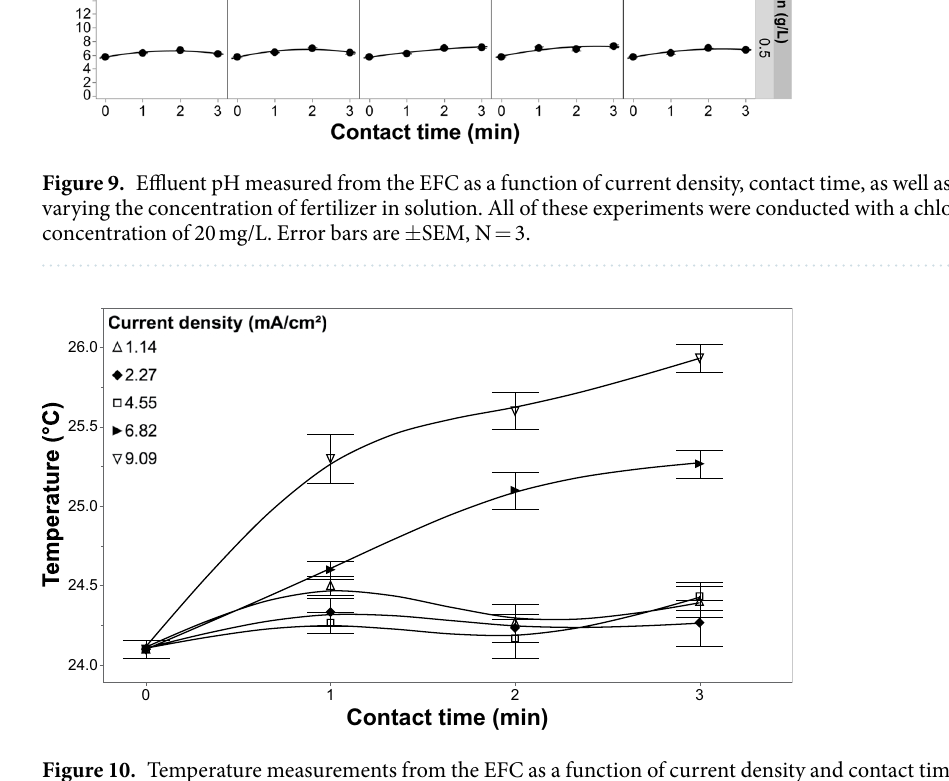
Figure 10. Temperature measurements from the EFC as a function of current density and contact time at a fertilizer concentration of 0.5 g/L and 20 mg/L of chloride in solution. Error bars are ± SEM, N =